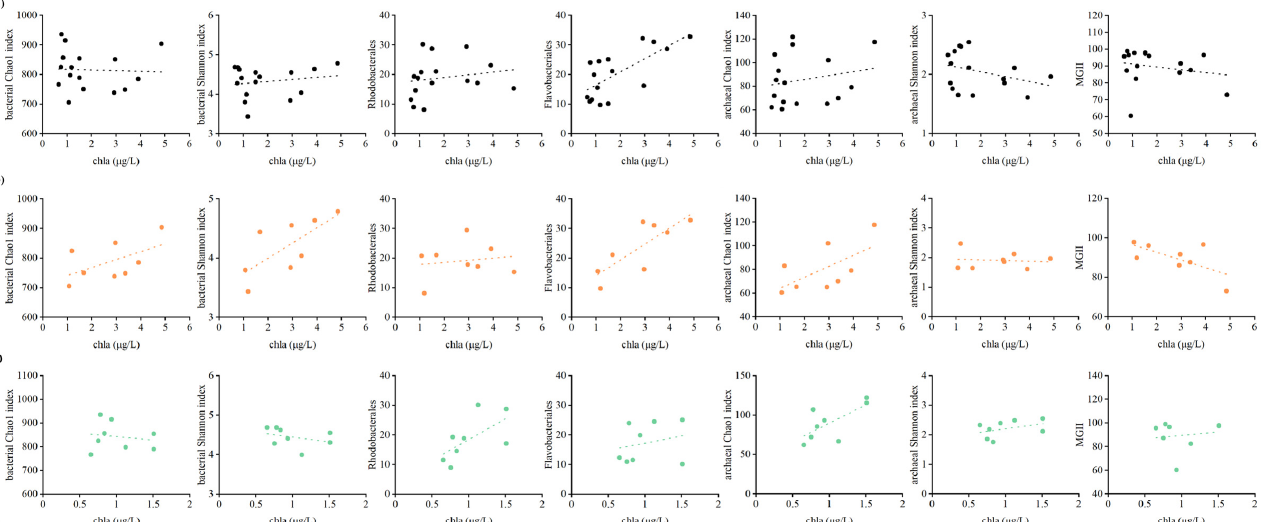
Figure 5. RDA analysis of environmental factors with bacterial community during the green tide ( a ), the outbreak ( b ) and decline ( c ) phase, and with archaeal community during the green tide ( d ), the outbreak ( e ) and decline ( f ) phase.